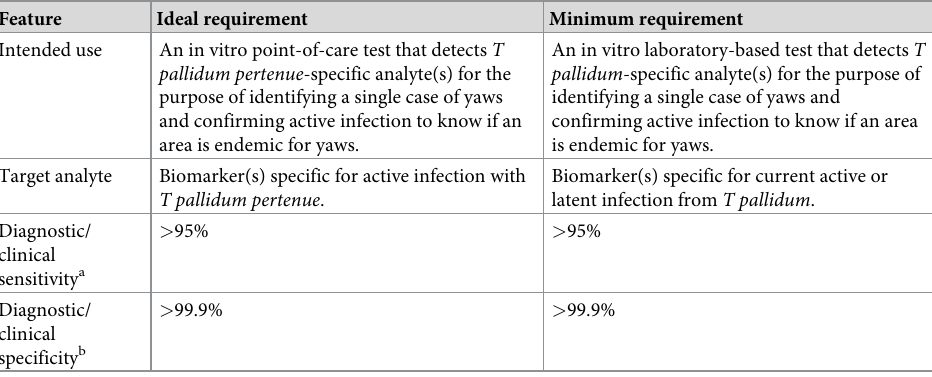
Table 1. Select characteristics of needed test for case detection.